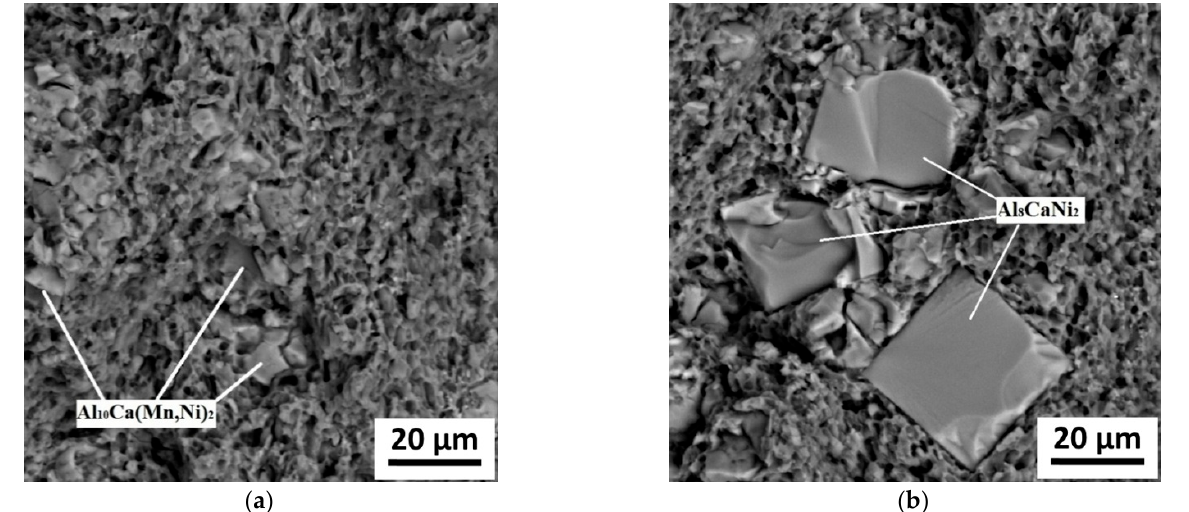
Figure 12. Fracture surfaces of the hot-rolled samples: ( a ) Al-8Ca-2Mn-1Ni; ( b ) Al-8Ca-2Mn-2Ni.